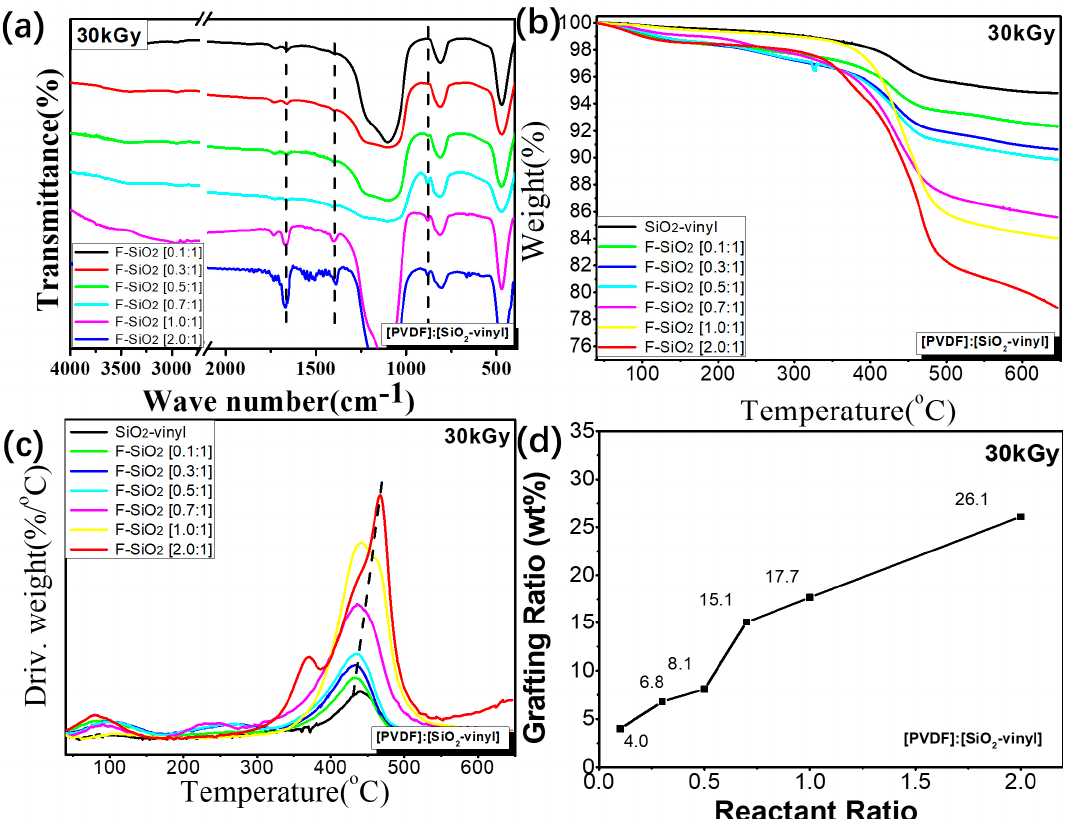
5 Figure 5. FT-IR ( a ), TGA ( b ), DTG ( c ) and the grafting ratio curves ( d ) of the F-SiO 2 with a di ff erent [PVDF] / [SiO 2 -vinyl] reactant ratio under 30 kGy, 17 h Gamma-radiation